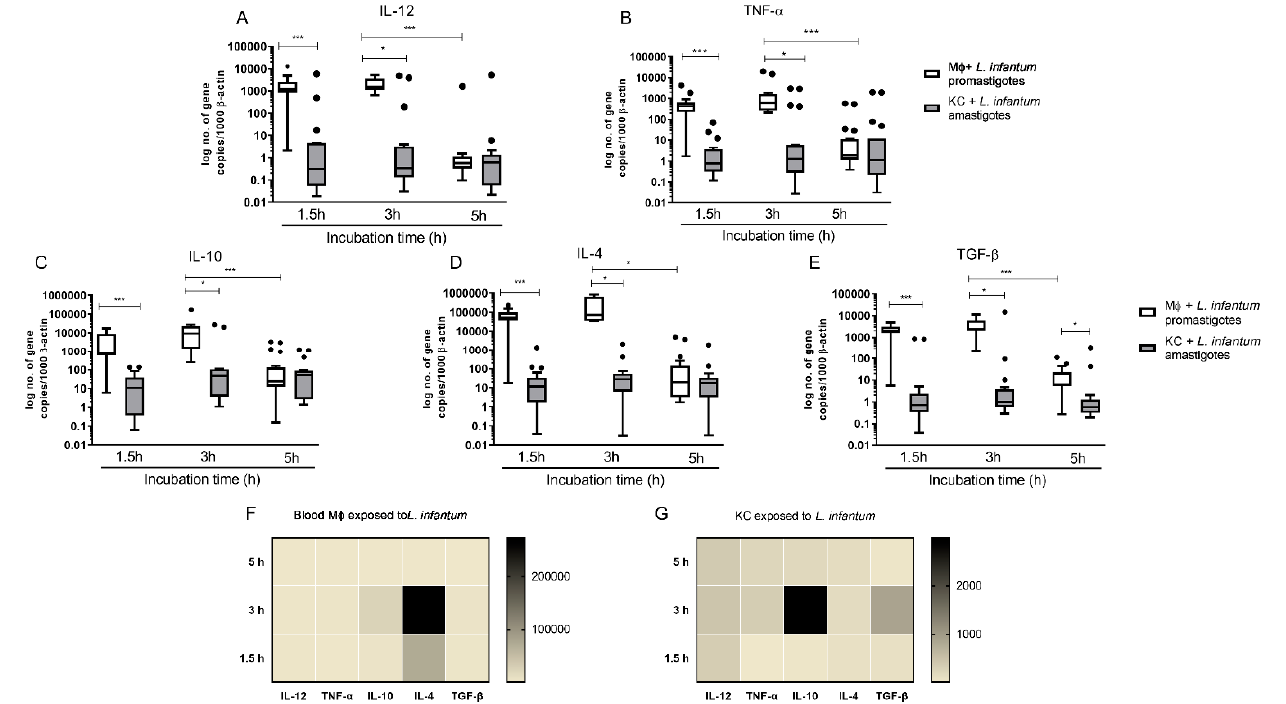
Figure 6. Gene expression of pro-inflammatory and anti-inflammatory cytokines by L. infantum infected KCs and blood-MØs. Blood-MØs were exposed to promastigotes and KCs to amastigotes. The number of copies of IL 12 ( A ), TNF- α ( B ), IL 10 ( C ), IL-4 ( D ), and TGF- β ( E ) was determined by real-time PCR at 1.5 h, 3 h, and 5 h. Results are expressed by whiskers box plots (Tukey) ( n = 10). Outlier values are indicated by black dots. The non-parametric Wilcoxon test was used for statistical comparisons. * ( p < 0.05) and *** ( p < 0.0001) indicate significant differences. Heat maps represent the accumulation of pro-inflammatory and anti-inflammatory cytokine mRNA by blood-MØ ( F ) and KCs ( G ) exposed to L. infantum parasites.